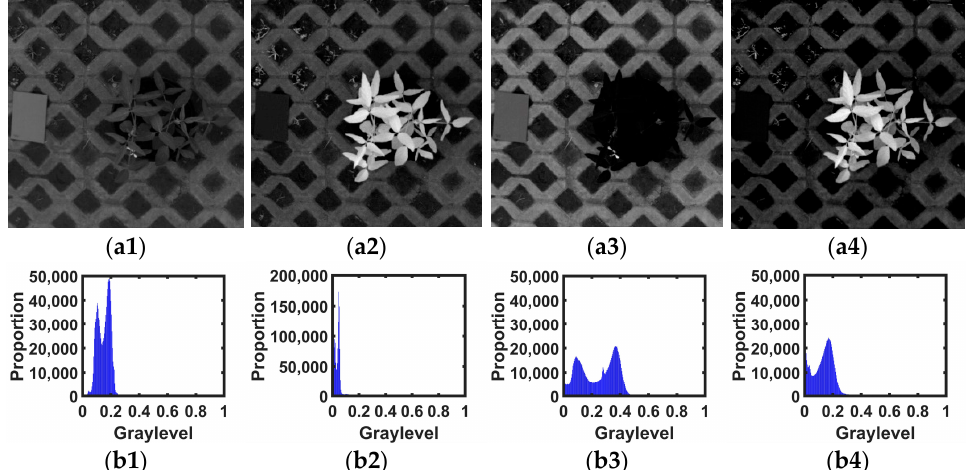
Figure 8. Mean filtering effect and corresponding histogram of a multispectral image for the soybean canopy: ( a1 ) GRE mean filter, ( a2 ) NIR mean filter, ( a3 ) RED mean filter, ( a4 ) REG mean filter, ( b1 ) GRE histogram, ( b2 ) NIR histogram, ( b3) RED histogram and ( b4 ) REG histogram.